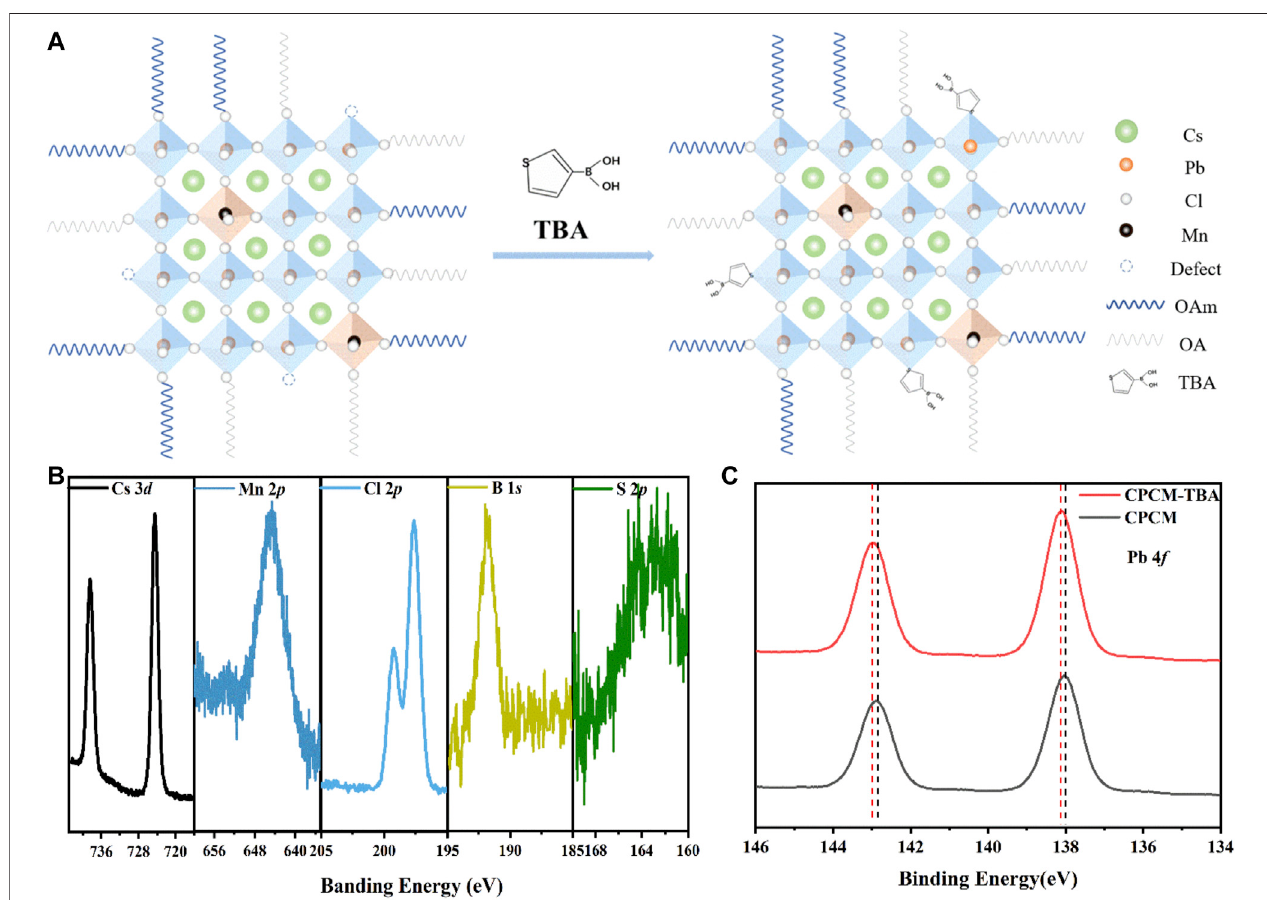
FIGURE3|(A) SchematicdiagramofthesynthesisofCPCMNCsaddedwithTBA. (B,C) High-resolutionXPSspectraforCs3 d ,Mn2 p ,Cl2 p ,B1 s ,S2 p ,andPb 4 f spectra of CPCM-TBA NCs.